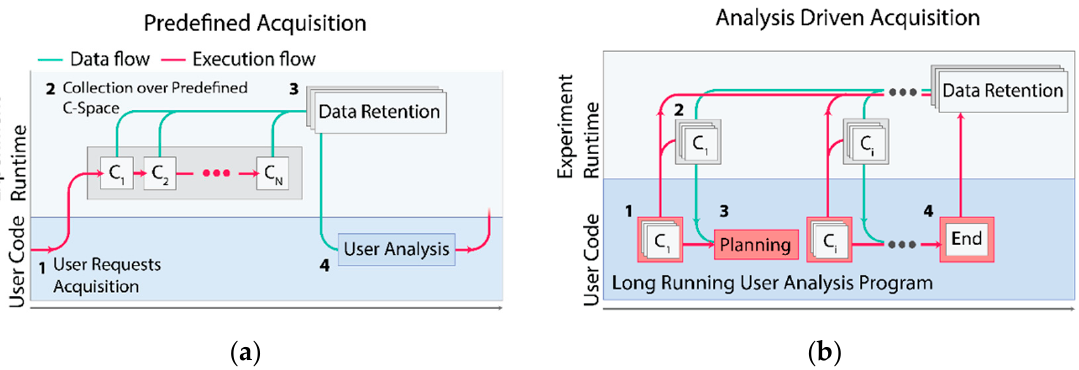
Figure 2. Analysis-driven acquisition. (( a ), 1–4) ( a , b ) Supported data collection paradigms. ( a ) In traditional conceptions of data acquisition, a scientist selects from a limited menu of predefined collection modes over a fixed coordinate space. Once requested ( 1a ), the system collects data over the states 𝐶 (cid:3036) ( 2a ) of this space until all data are available, at which point the system retains the data for later analysis ( 3a ). The scientist inspects the data ( 4a ) and the process is repeated. ( b ) Analysis- in-the-loop conception of data acquisition. A scientist submits a program to the acquisition system (1b). The program can issue acquisition instructions that are validated and performed by the acqui- sition system ( 2b ) and intermediate data are collected as well as provided back to the program.